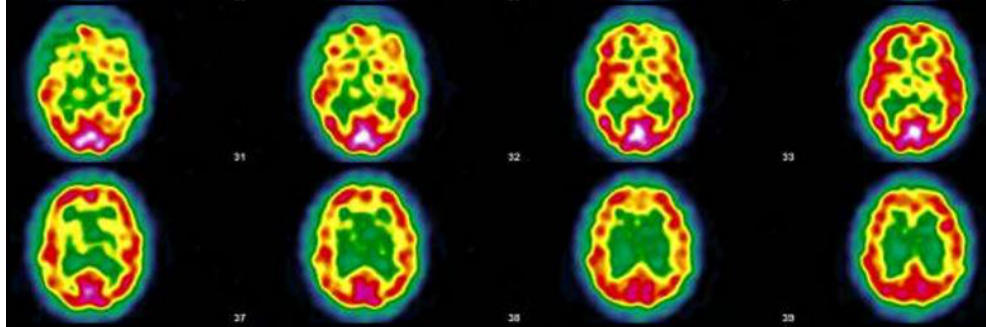
Figure 4. Patient MGA017; SPEC-CT (ECD Tc-99m); The image shows eight brain sections of the same patient. The red areas indicate a good tracer fixation and thus a good perfusion. Yellow patches appearing in red areas indicate hypofixation and thus ischemia. Protocol: “ Heterogeneous tracer fixation with bilateral temporal, bilateral frontal, left posterior parietal, right parieto-occipito-temporal hypofixation. Discrete preservation of the sensory-motor cortices. The fixation in front of the grey nuclei is correct. Right cerebellar hypofixation. Cortico-subcortical atrophy with periventricular hypocaptation as an indirect sign. Conclusion: Scintigraphic examination compatible with a cerebral pathology of vascular type. Moderate cortico-subcortical atrophy. ” (Images and protocol; Drs Bouazza & Mahy, Vesale hospital, ISPPC, Belgium).